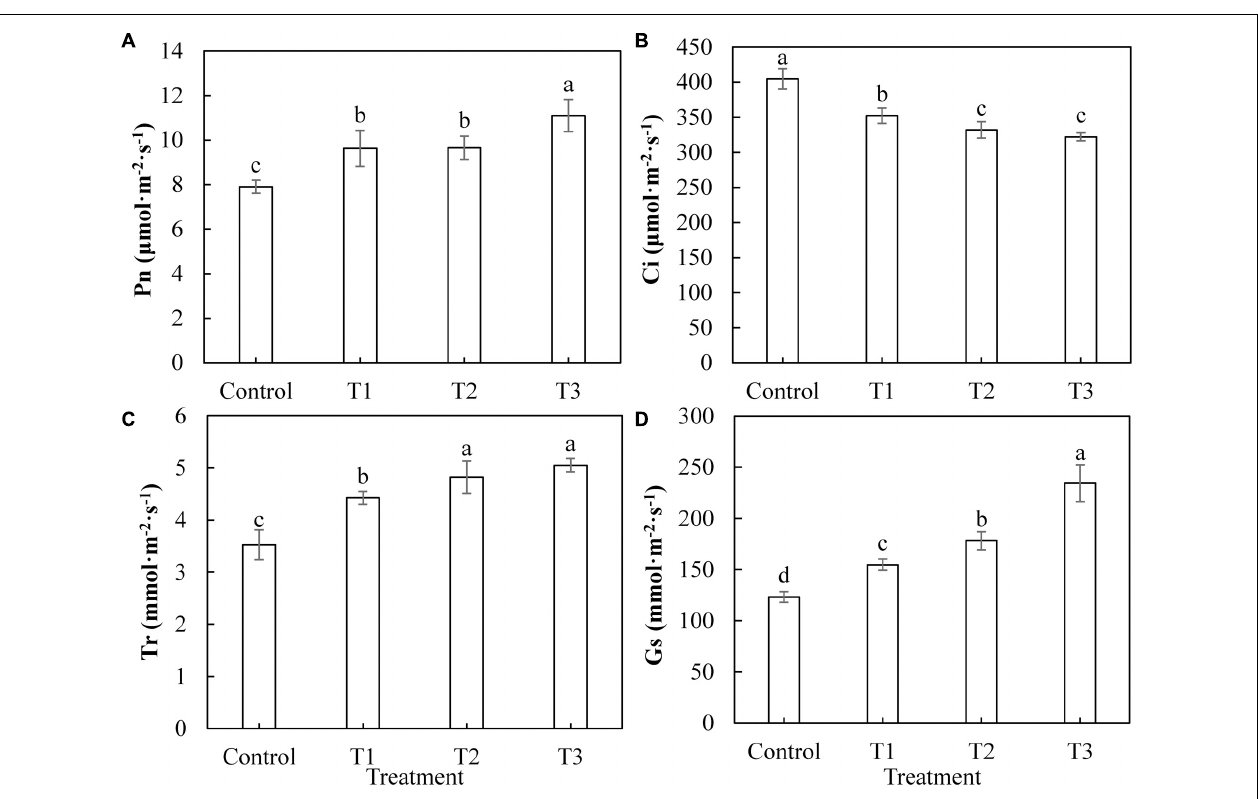
FIGURE 4 | Effects of supplemental LED light duration on net photosynthetic rate (A) , intercellular CO 2 concentration (B) , transpiration rate (C) , and stomatal conductance (D) in cucumber leaves. After supplemental LED light treatment for 30 days, the third leaf downward from the top of the cucumber was selected from 9:00 am to 11:00 am on sunny days to measure the gas exchange parameters. Values are expressed as mean ± SE ( n = 3). Bars that are significantly different based on the Duncan’s multiple range test ( p < 0.05) are indicated with different lowercase